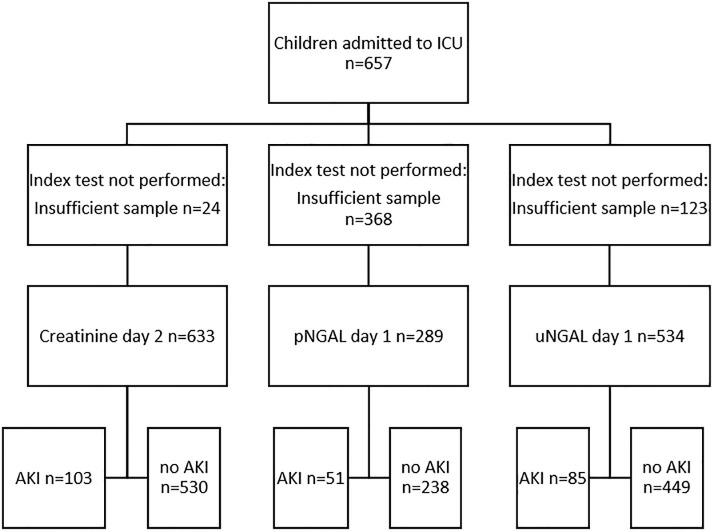
STARD flowchart.